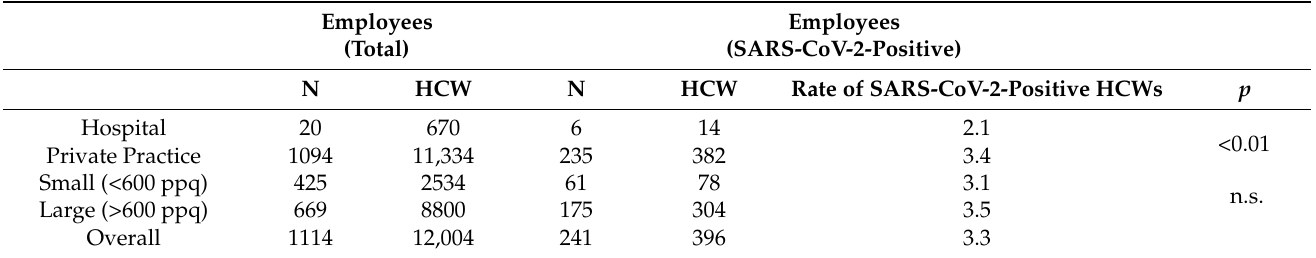
Table 2. Distribution of SARS-CoV-2-positive healthcare workers in questioned private